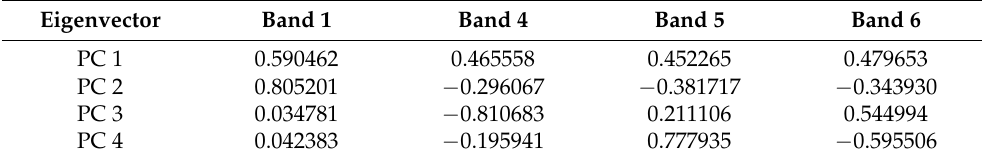
Table 5. Eigenvector matrix of selected bands for mapping argillic zone derived from SPCA.